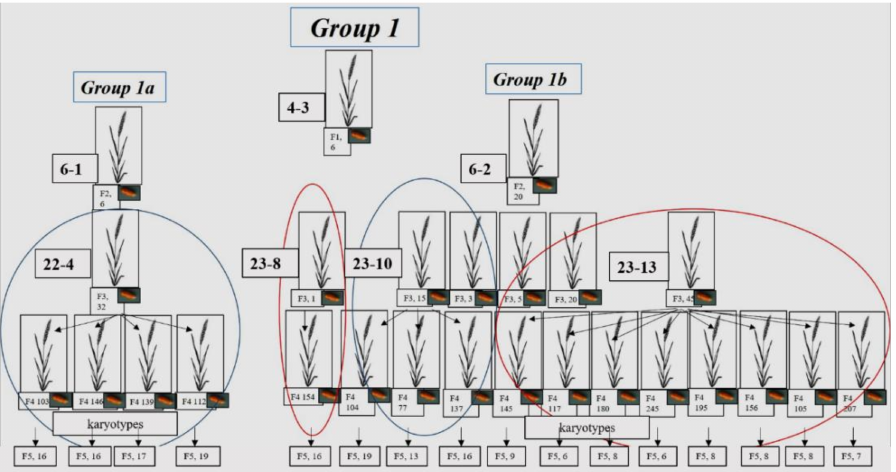
Figure 1. Development of wheat–rye hybrids of Group 1. The scheme shows individual plants from the F 1 –F 4 generations, and the number of seeds in these plants. For the F 5 generation, the number of plants analyzed for karyotype is shown.